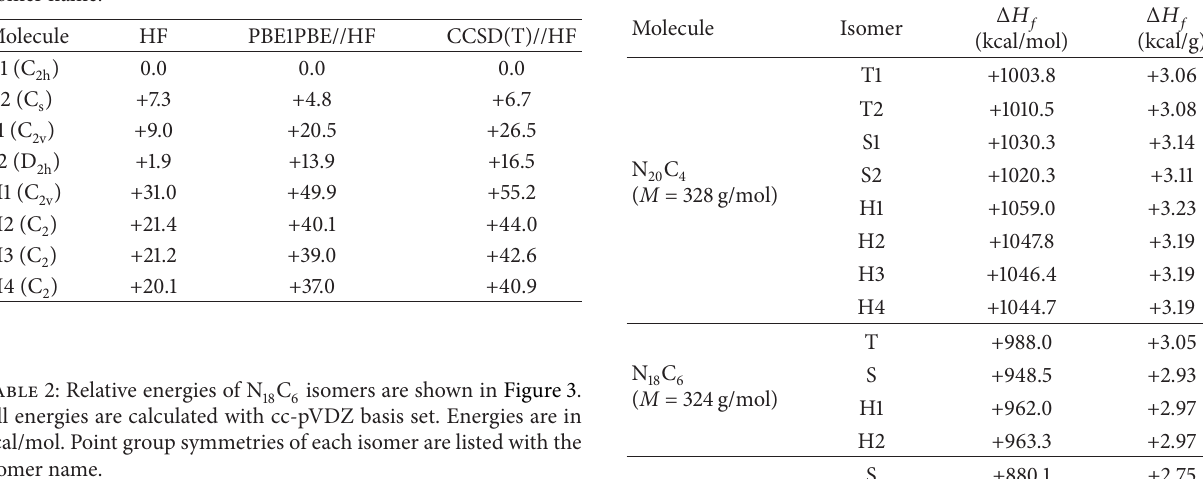
Table 4: Heat of formation for N gies are calculated using CCSD(T)//HF energies. Energies are in kcal/mol and